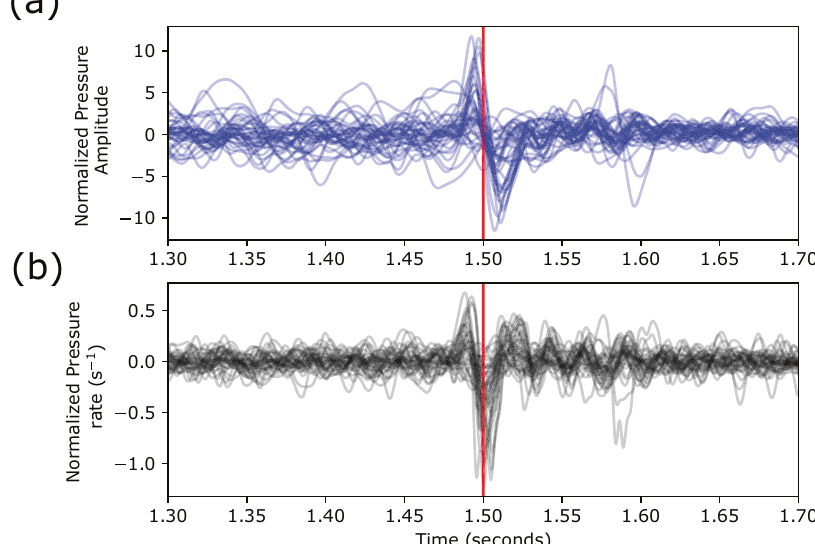
Fig. 3 Timing of bubble events relative to low-frequency pressure fl uctuations. A subset of the low-frequency ( fi ltered between 2 and 40 Hz) pressure signals ( a , blue), and the corresponding pressure rate ( b , black), aligned by time of bubble nucleation (red lines), showing that bubble nucleation preferentially occurs at the time of maximum decompression rate. The amplitudes have been normalized by removing the mean and dividing by the standard deviation.